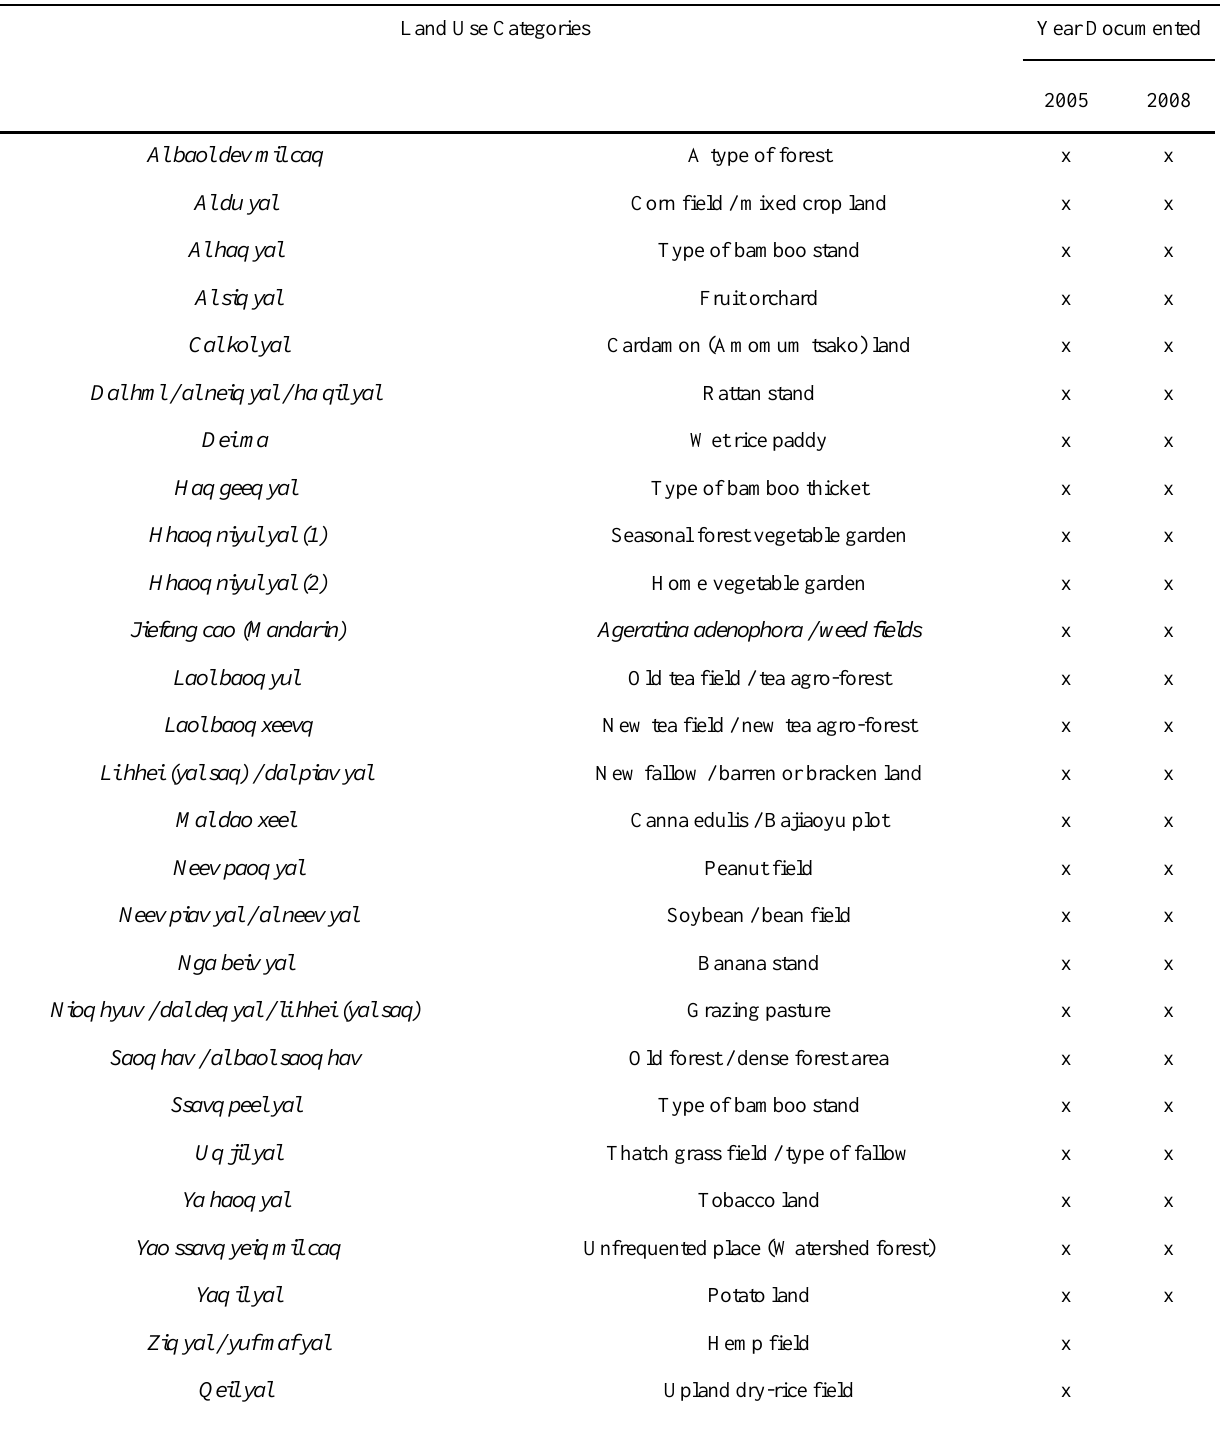
Table 1. Comparison of land use categories documented during 2005 and 2008 data collection periods in